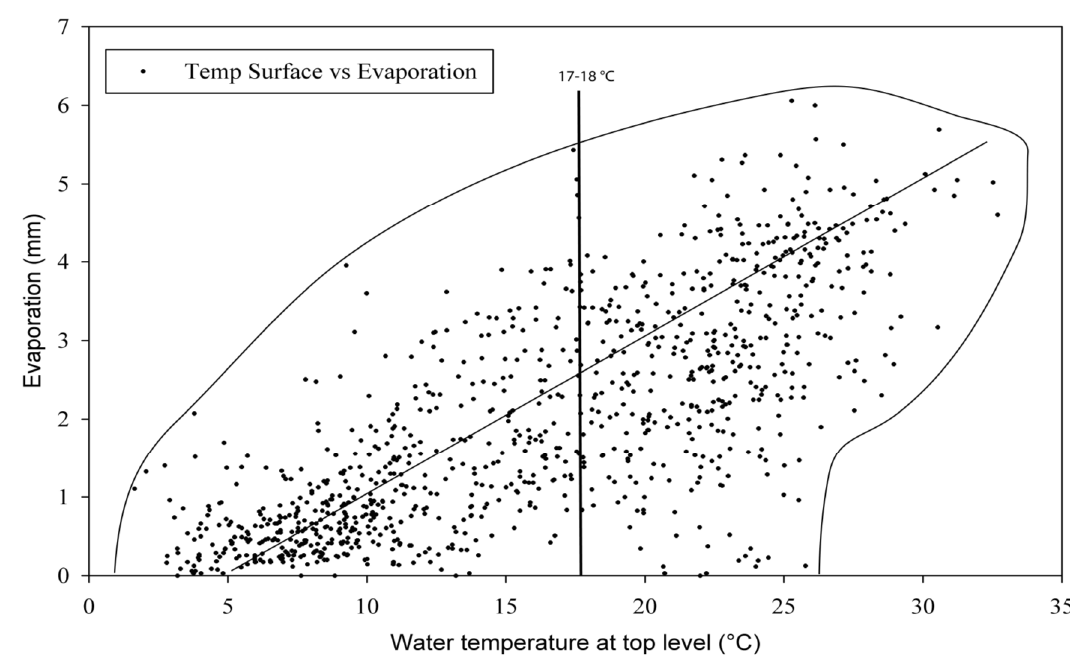
Figure 12. Evolution of evaporation with air temperature.